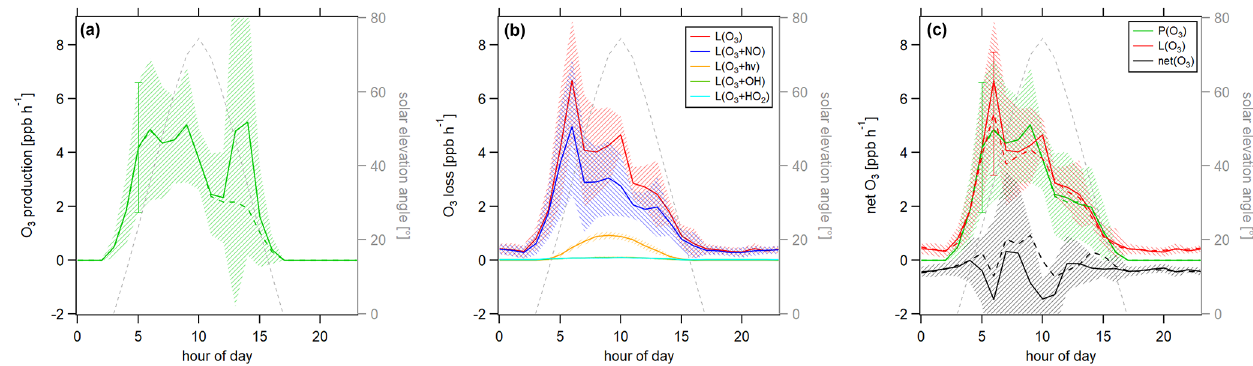
Figure 8. Diurnal profiles of (a) ozone production P (O 3 ), (b) ozone loss L (O 3 ) and (c) ozone net terms during the CYPHEX campaign in 2014. Solid lines show the hourly averaged O 3 production and loss terms, based on the point-by-point calculation of simultaneous parameter measurements. The uncertainty from the atmospheric variability is represented by the 1 σ error shades. For the dashed lines, all measurement parameters were averaged first, followed by the calculation of hourly O 3 production and loss terms. The uncertainty is mostly dominated by the atmospheric variability in all parameters and is exemplarily shown by the error bar for one point for each production and loss term. Please find the temporal development of production and loss terms throughout the campaign in Fig. S8.